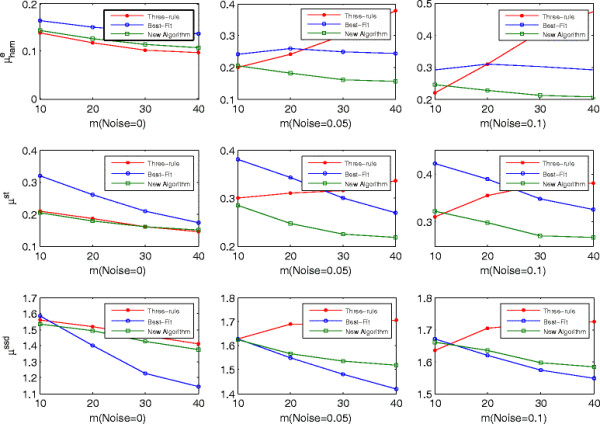
Comparison ofμhame,μhamst,
μ

ssd
for the three algorithms with 0%, 5%, and 10%noises (
K
 
= 3).